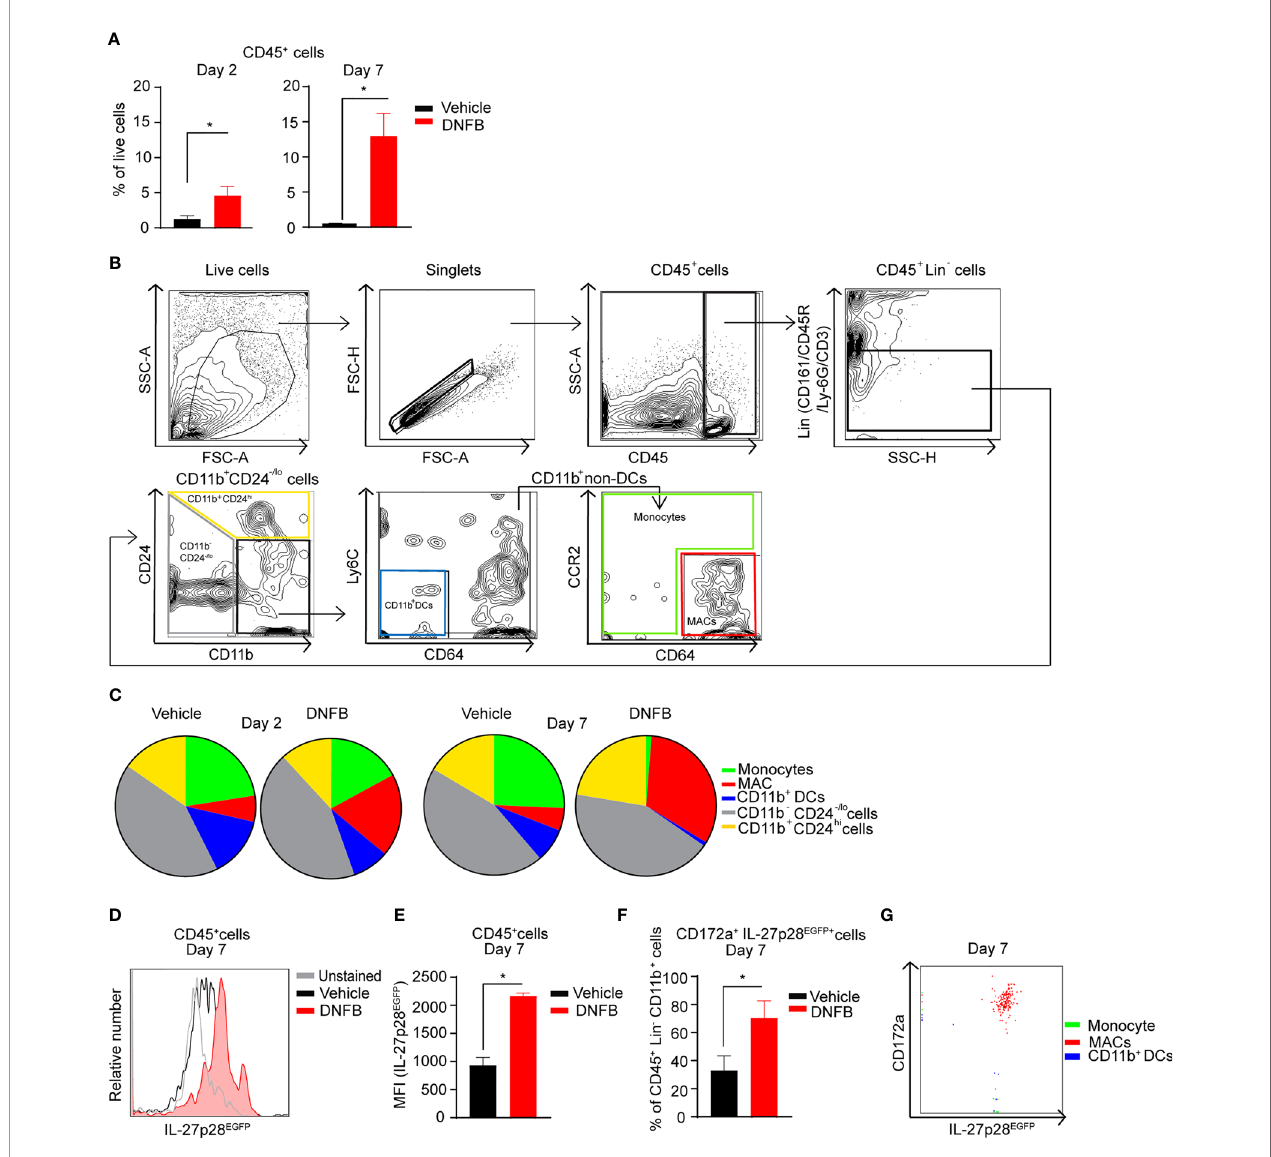
FIGURE 1 | Exposure to allergen upregulates IL-27 in murine MACs during CHS. (A) Quantitative analysis of CD45 + hematopoietic cell frequency (in living cells) in DNFB-treated and vehicle-treated ear skin of the CHS mice (2 and 7 days post-DNFB elicitation). The data are represented as mean ± standard error of the mean (SEM) from at least 4 mice per group, *p < 0.05 (unpaired Student ’ s t test). (B) Gating strategies for skin myeloid cell population identi fi cation in the CHS mouse model. Single-cell suspensions of mouse ear skin treated were prepared. After excluding dead cells, as well as Lin + ; including T cells, NK cells, B cells, and granulocytes, the remaining CD45 + cells were analyzed for expression of CD24 and CD11b. CD11b + CD24 -/lo cells were further analyzed for Ly-6C, CD64, and CCR2 expression. The CD11b + non-DCs fraction was separated into monocyte and macrophages (MACs) populations, respectively. (C) Pie charts summarizing immune cell distribution (gated on CD45 + Lin - cells) from mouse ear skin at 2 and 7 days post-DNFB elicitation. The data represent the mean of at least 4 mice per treatment group. (D) Histogram from representative fl ow cytometry analysis for IL-27p28 of vehicle-treated and DNFB-treated ears gated on CD45 + cells. Data shown are representative of at least 4 mice per group. (E) Data presented shows median fl uorescence intensity (MFI) of IL-27p28 in the CD45 + population from ll-27p28 EGFP mice at 7 days post DNFB-elicitation versus vehicle controls from at least 4 mice per group and are depicted as mean ± SEM, *p < 0.05 (unpaired Student ’ s t test). (F) Quantitative analysis of CD172a + IL-27p28 EGFP+ cell frequency of CD45 + Lin - CD11b + cells in DNFB-treated and vehicle-treated ear skin. At least 4 mice per group and summarized as mean ± SEM, *p < 0.05 (unpaired Student ’ s t test). (G) Representative fl ow cytometric overlay dot plots of gated monocytes, MACs, and CD11b + DCs at 7 days post-DNFB elicitation on mouse ear skin demonstrating CD172a and IL-27p28 expression from at least 4 mice per